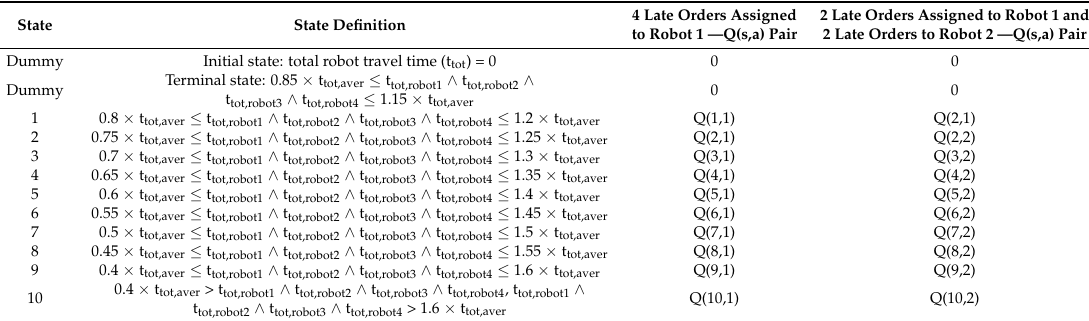
Table 6. Policy table for the scheduling agent.